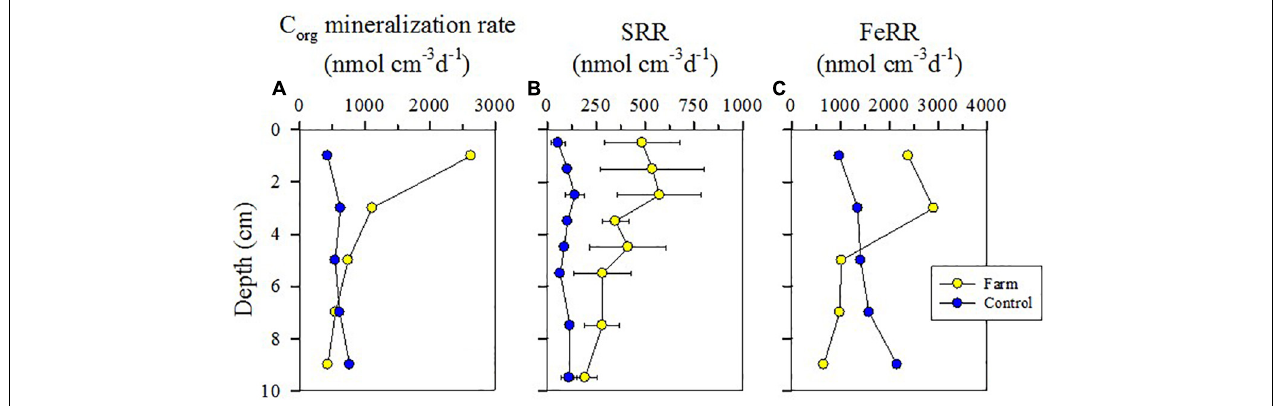
FIGURE 3 | Vertical profiles of anaerobic C org mineralization rates (A) , sulfate reduction rates (SRRs) (B) , and iron reduction rates (FeRRs) (C) in the fish farm and control